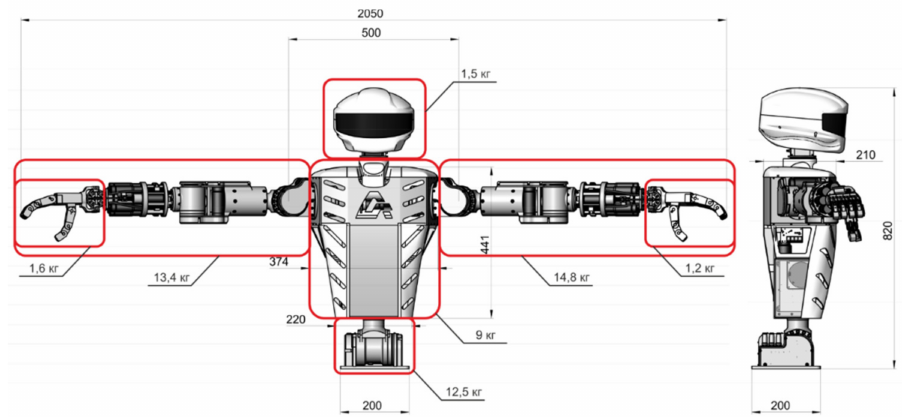
Figure 4. The torso anthropomorphic robot, model SAR-401 (without stand). The general characteristics of the robot SAR-401: weight—70 kg; height—820 mm; a span of manipulators—2050 mm; number of video cameras—2 (stereo vision